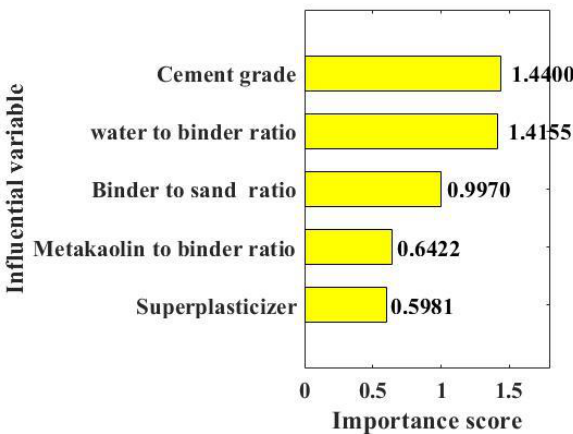
Figure 5. Variable importance of the compressive strength.